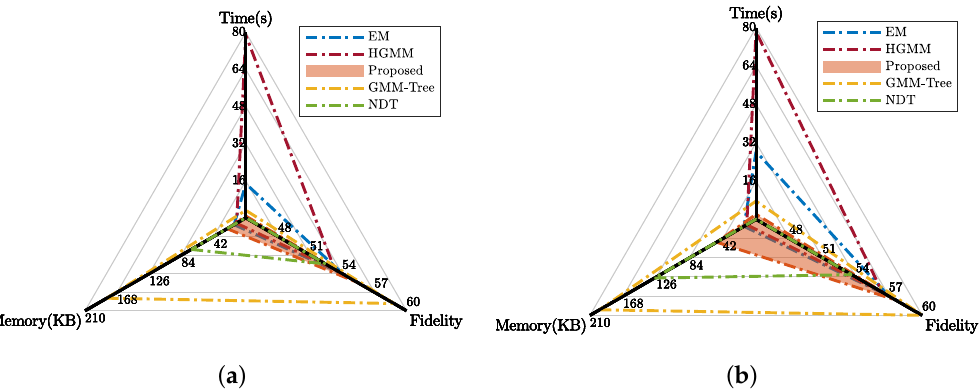
Figure 8. The mean value of fitting time, fidelity, and memory footprint of Lidar datasets using different approaches. ( a ) Street; ( b ) Campus.